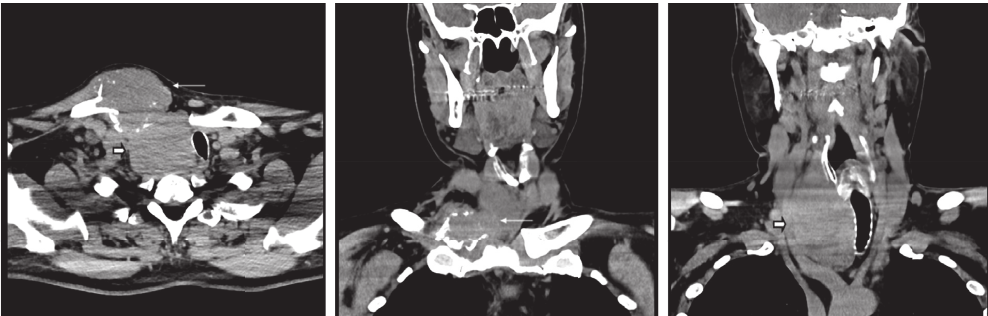
Figure 2: Axial CT image of the soft tissues of the neck (left image) demonstrating a heterogeneous mass within the right clavicular head, which is expansile with associated bony destruction (thin white arrow). There is also mass-like enlargement of the right thyroid lobe (short thick arrow). A coronal CT image of the soft tissues of the neck (middle image) also shows the destructive mass in the right clavicular head with soft tissue component (thin white arrow). A coronal CT image of the neck soft tissues more posterior in position (right image) demonstrates the mass-like enlargement of the right thyroid lobe (short thick